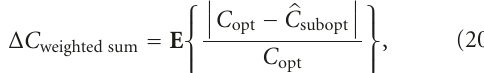
Figure 3: Average normalized weighted sum-rate deviation versus iterations for K = 2 and 4 users, M = 8 subcarriers, and SNR =